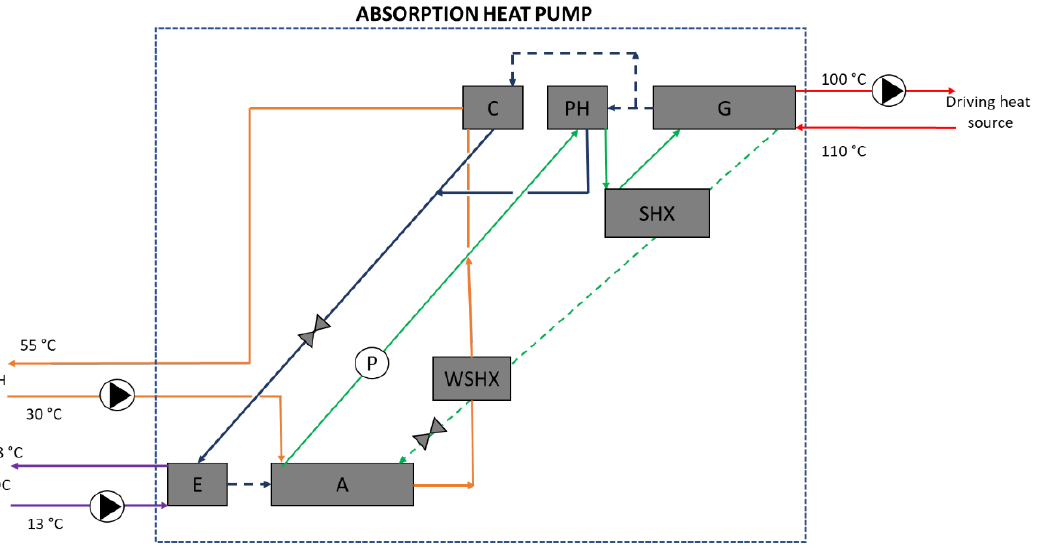
Figure 7. Layout for the simultaneous heating and cooling for 4th generation DHC